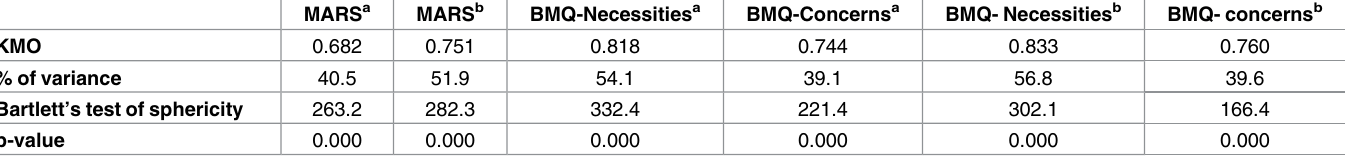
Table 2. Principal component analysis results for MARS and BMQ-specific for parents and children.